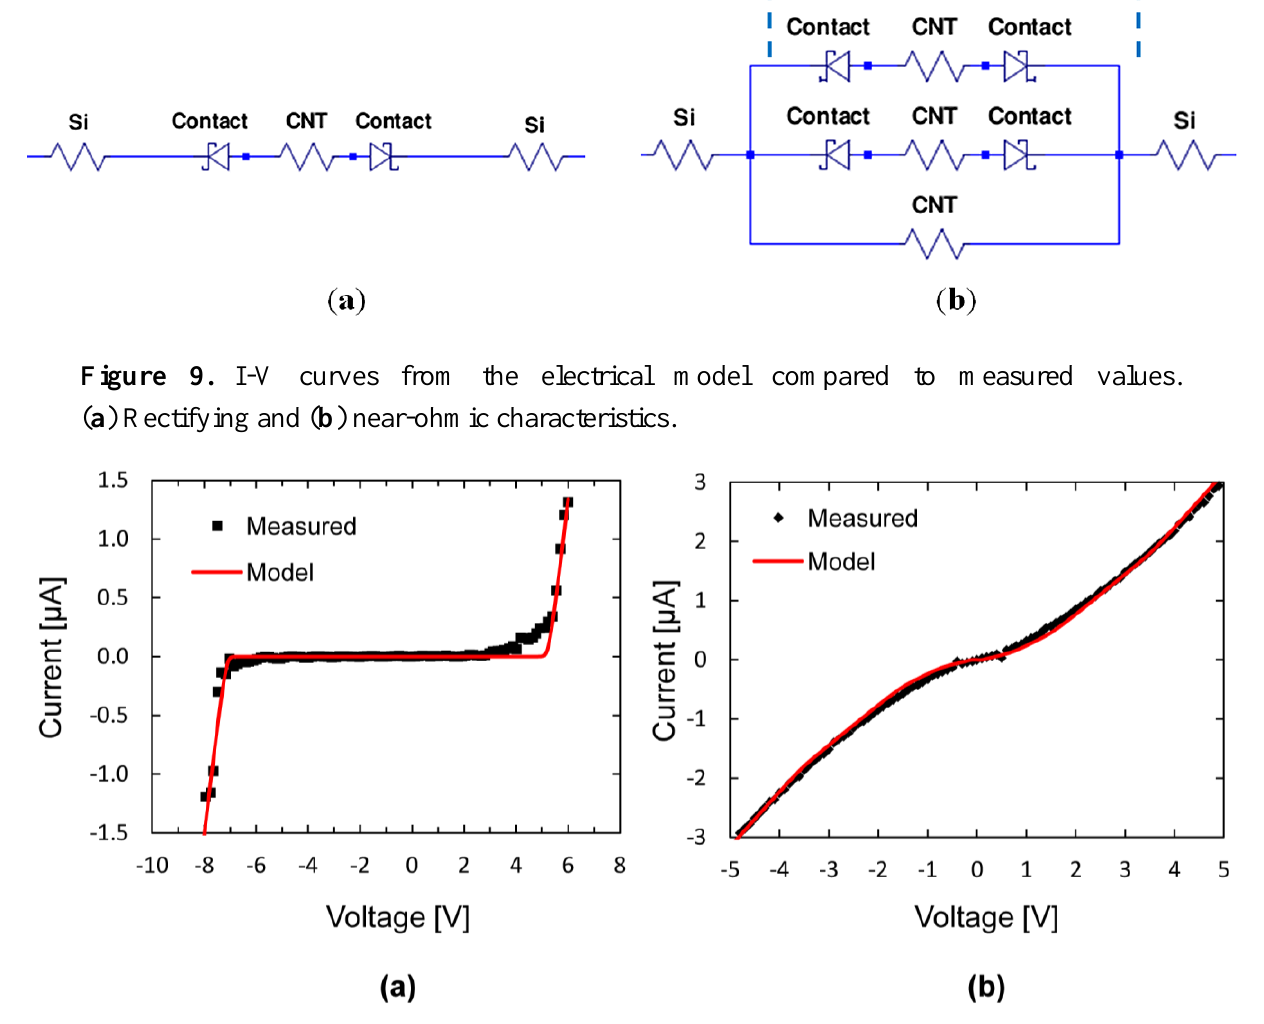
Figure 10. SEM pictures of two observed contact modes for CNTs connecting to the secondary bridge. ( a ) CNT in end contact with the sidewall of Si microbridge; ( b ) CNT in side contact with the top surface of the Si